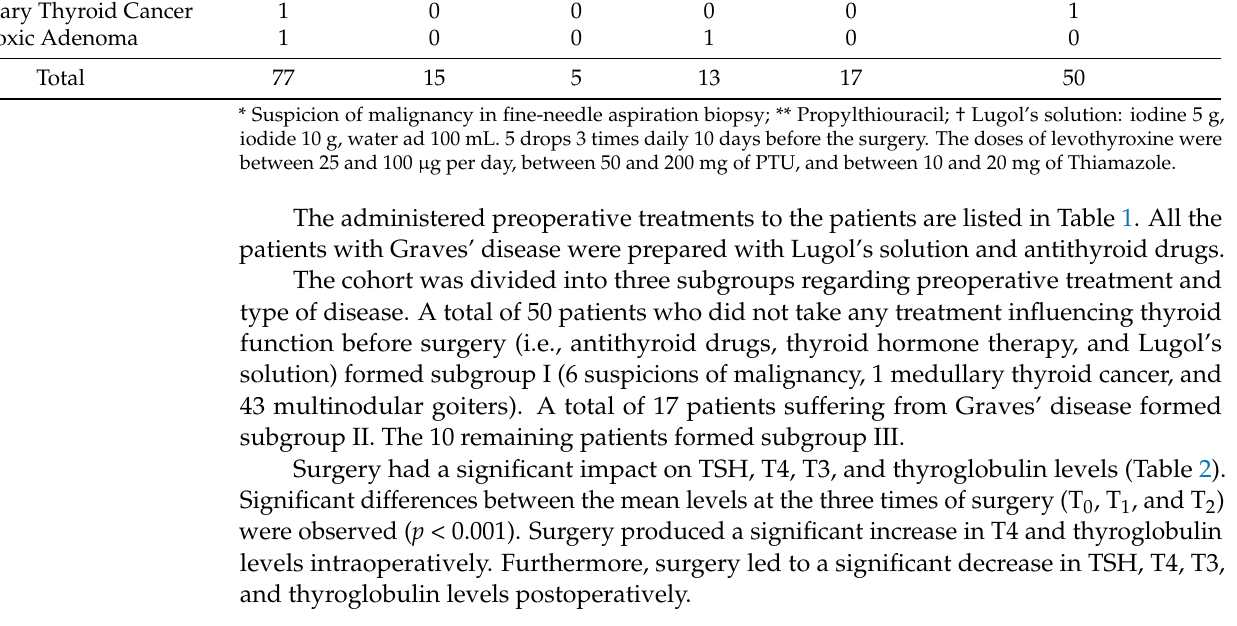
Table 2. Mean levels and confidence intervals of TSH, T4, T3 and thyroglobulin perioperative in the entire